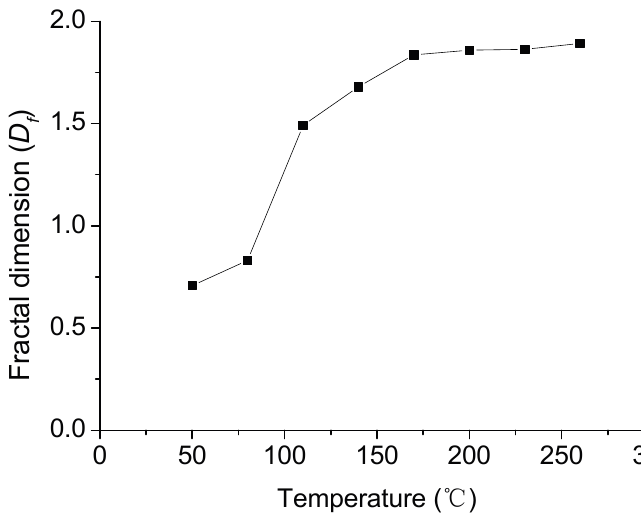
Figure 8. The relation between fractal dimension and